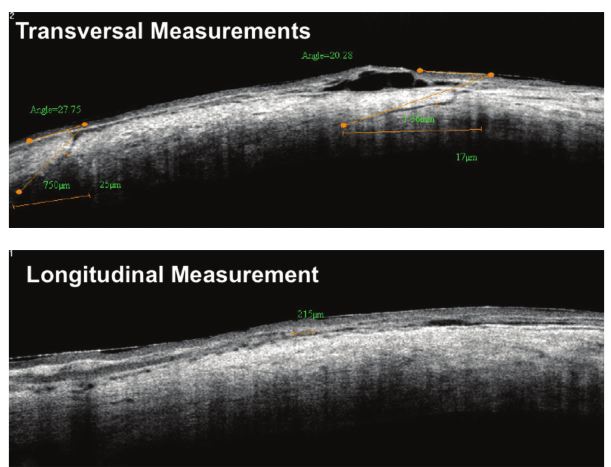
Figure 1: Images of the 25-gauge sclerotomies on postoperative. A cross line scan parameters of transverse and longitudinal measure- ments illustrated with a